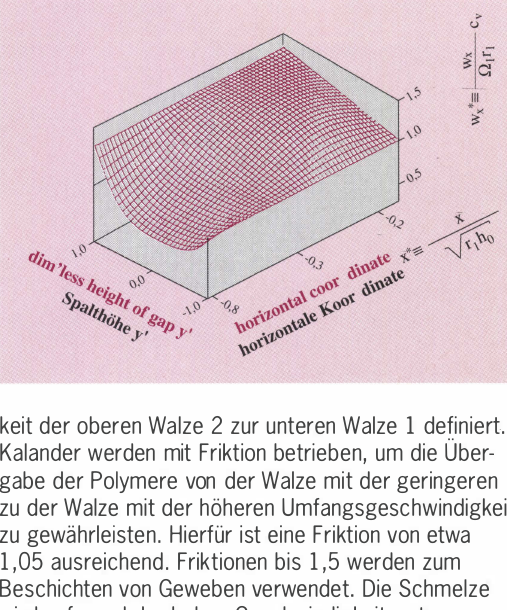
Abb. 6: Die Horizontal­ geschwindigkeit im Kalanderspalt fur eine Friktion von f = 1,4 Fig. 6. The horizontal velocity in the calender nip for a friction ratio of 1.4